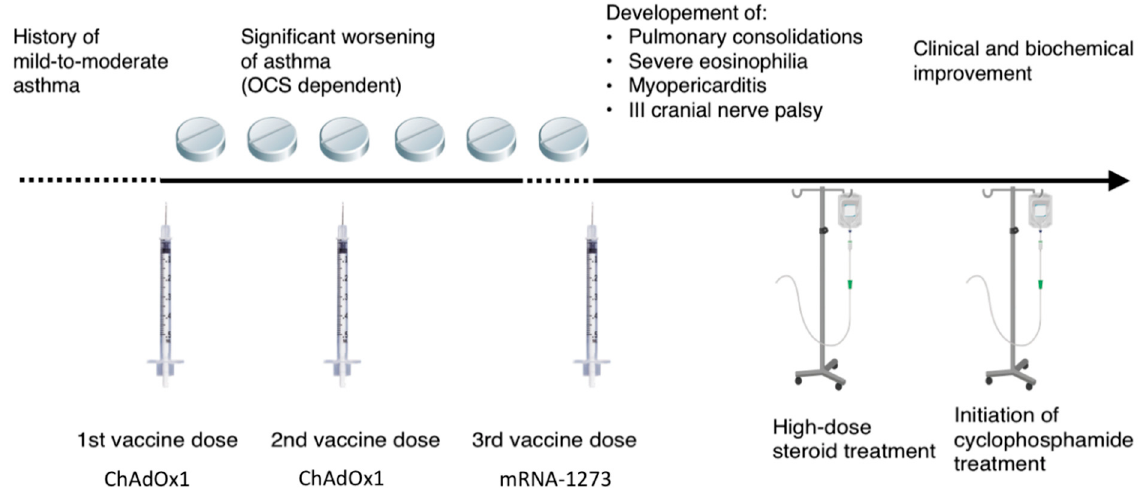
Figure 1. Timeline of clinical events.